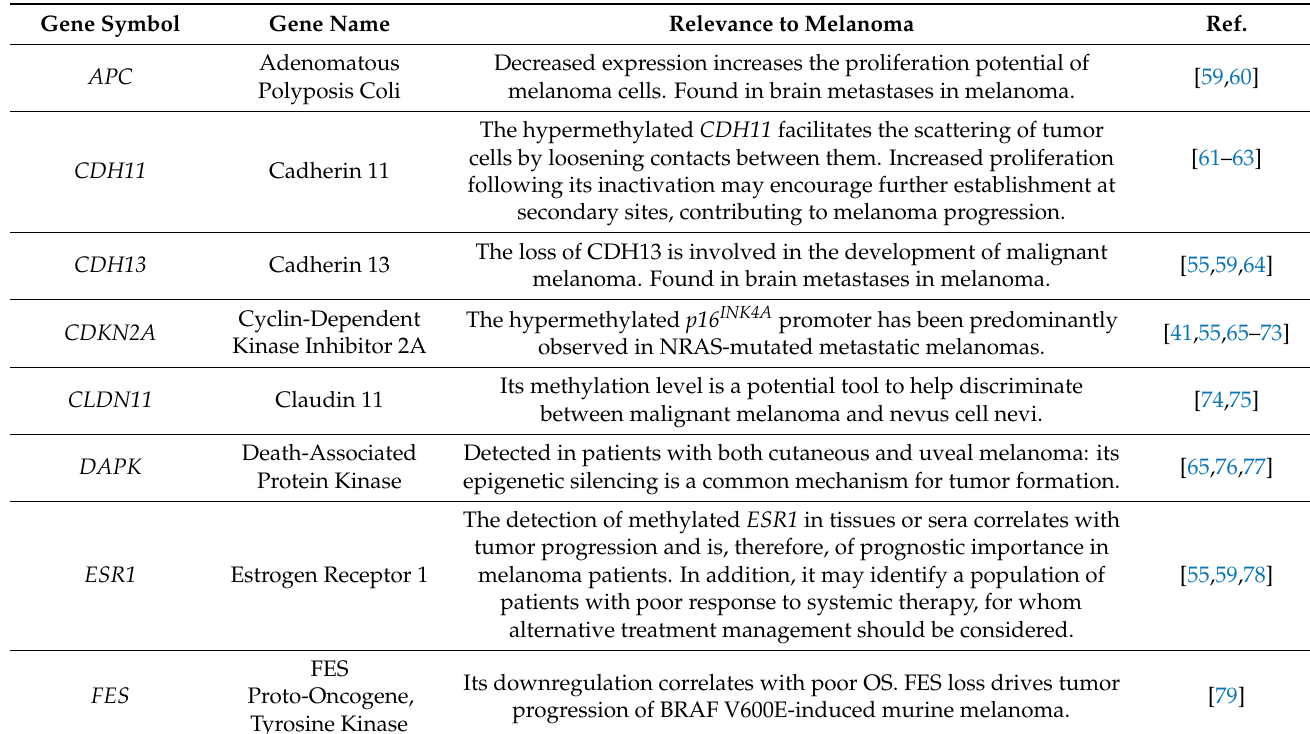
Figure 2. Pathways and genes involved in melanoma development. Aberrantly methylated genes and signal transduction pathways frequently altered during melanoma development and/or progression. ( a ) Shows the MAPK and PI3K-Akt pathways; while ( b ) depicts the p53, Rb, retinoic acid signaling, and DNA repair pathways. Hypermethylated TSGs are marked with a red dot; the alteration induced in the downstream pathway by TSG hypermethylation is represented by a red cross. The diagrams were created by means of https://biorender.com/ (accession date 8 October 2021). Table 1. Hypermethylated genes in